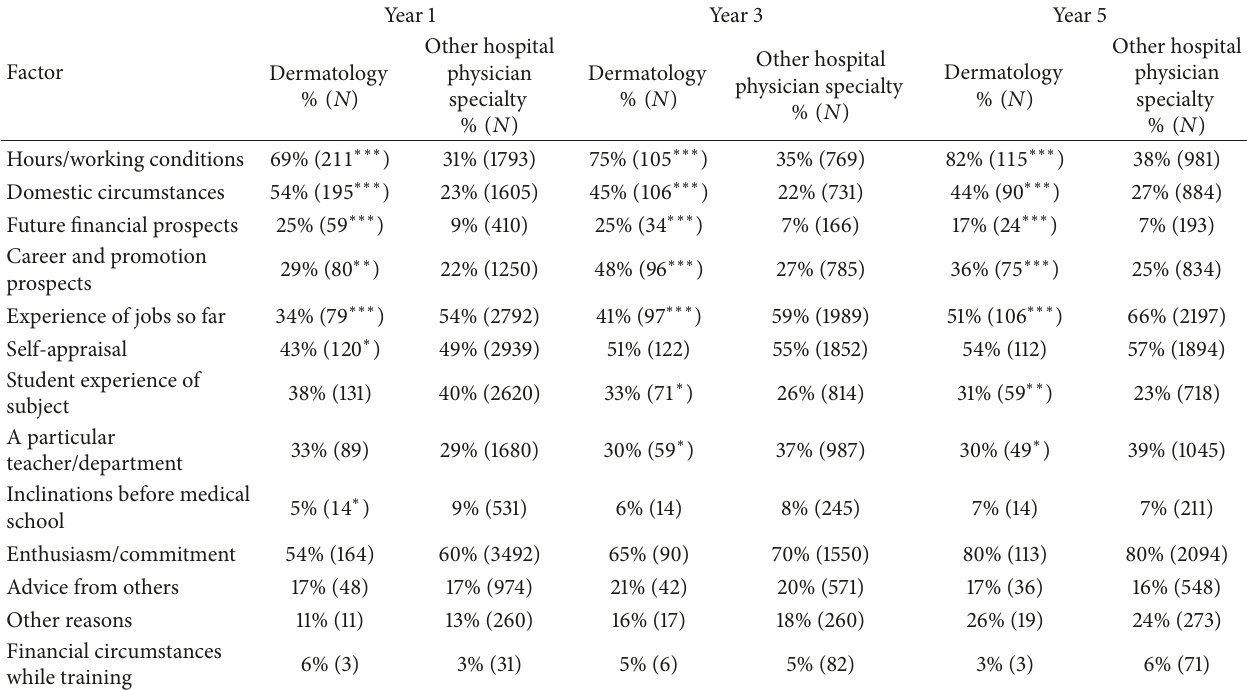
Table 4: Numbers and percentages of doctors who specified each factor affecting their career choice “a great deal.”